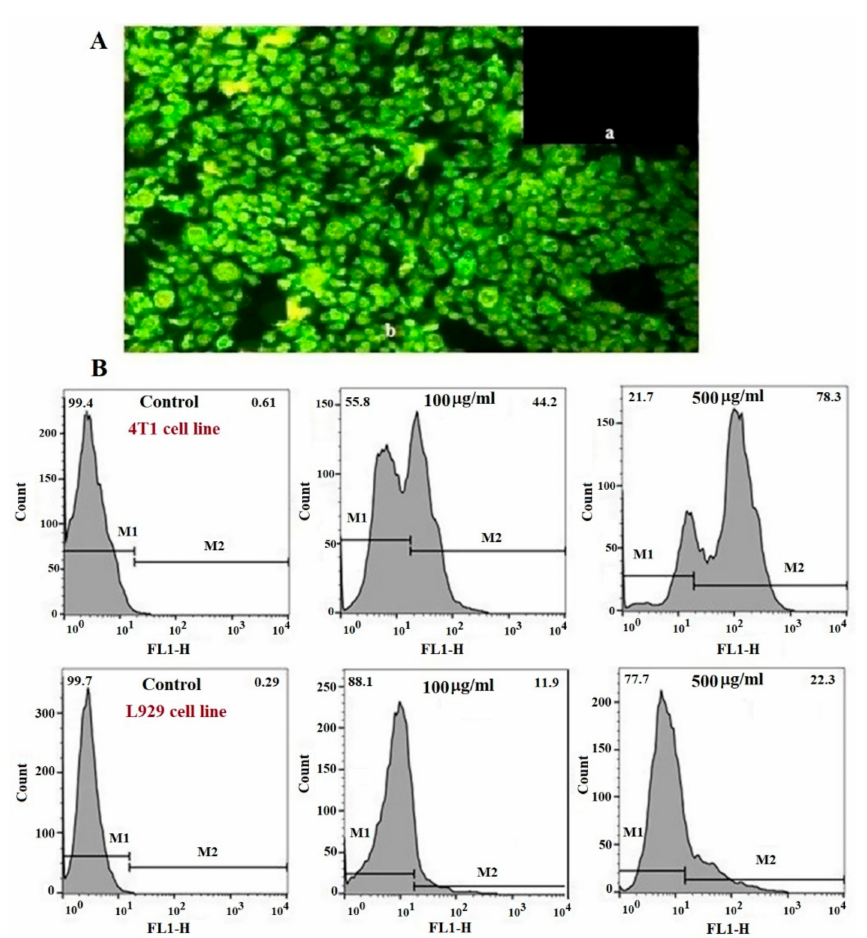
Figure 7. ( A ): ( a ) Cellular uptake of L929 by fluorescence microscopy in 500 µ g/mL after 24 h. ( b ) Cellular uptake of 4T1 by fluorescence microscopy in 500 µ g/mL after 24 h. ( B ) Cellular uptake of control, L929, and 4T1 by flow cytometry in 100 and 500 µ g/mL after 24